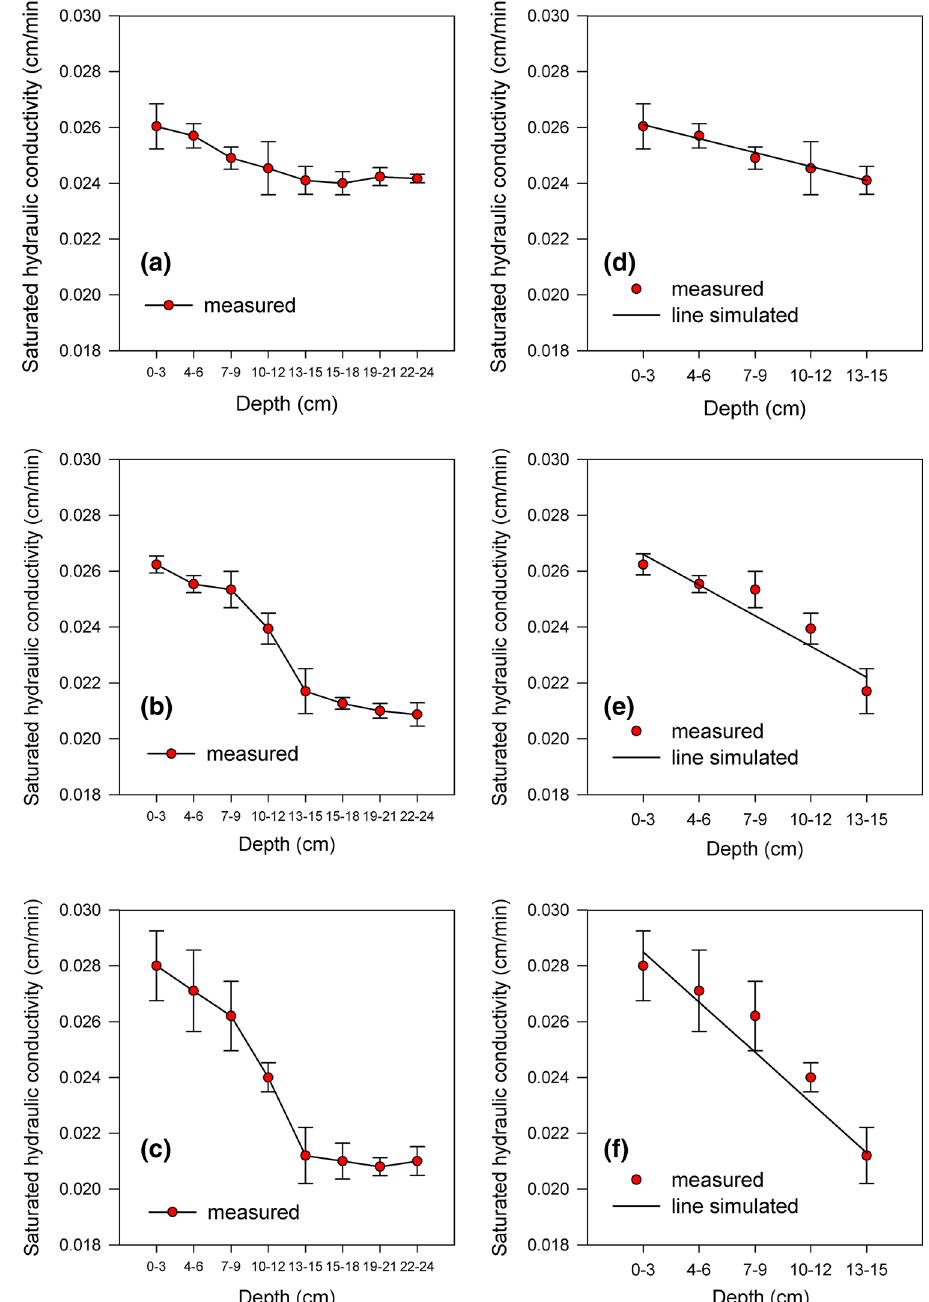
or plough pan ( a ); no soybean coverage with a plough pan ( b